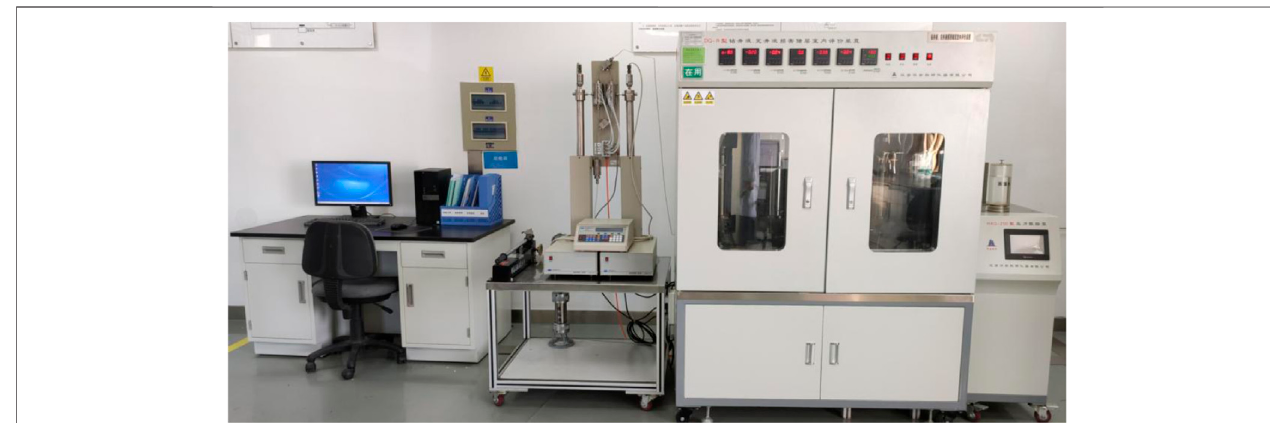
FIGURE 5 | Core displacement equipment.